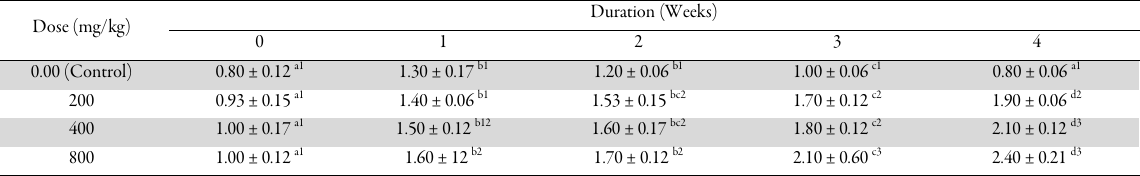
Table 3. Effect of Lipton tea aqueous extract on HDL-C (mmol/l) of normal albino rats Dose (mg/kg)